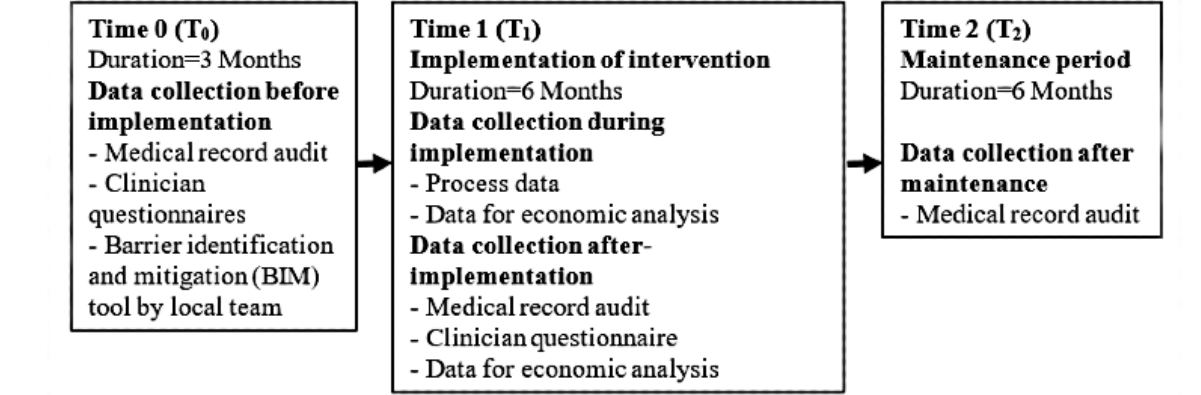
Figure 1. Study design and data collection